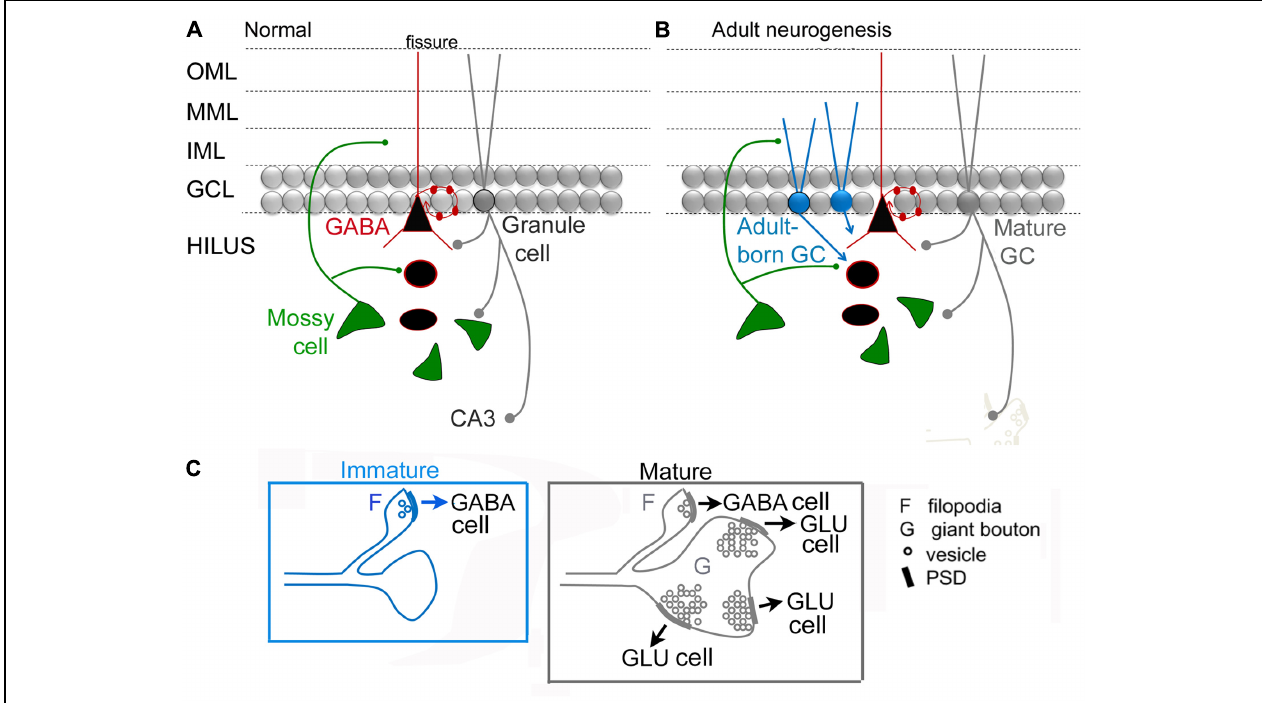
FIGURE 4 | Dentate gyrus circuitry with and without adult-born GCs. (A,B) . A previous (A) and updated (B) view of DG circuitry with a young adult-born GC (blue) depicted at an immature stage of development when their dendrites extend only a short distance into the molecular layer. MCs are the primary glutamatergic input at this time. Adult-born cells are not completely mature and their axon preferentially innervates GABAergic neurons. At a mature stage they develop more of their “giant” boutons which innervate thorny excrescences of mossy and pyramidal cells. We hypothesize that the adult-born GCs primarily innervate